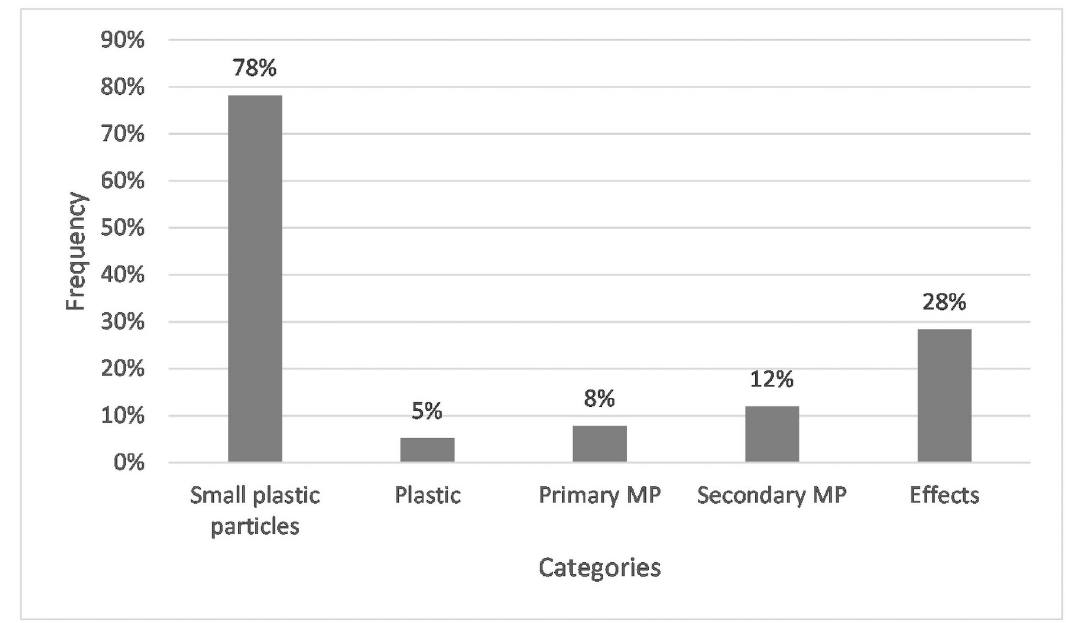
Fig 4. Frequencies of students whose answers assigned to the corresponding categories for Q1: “What do you understand by the term microplastics?” N = 267. Open question with categories formed from students’ answers.